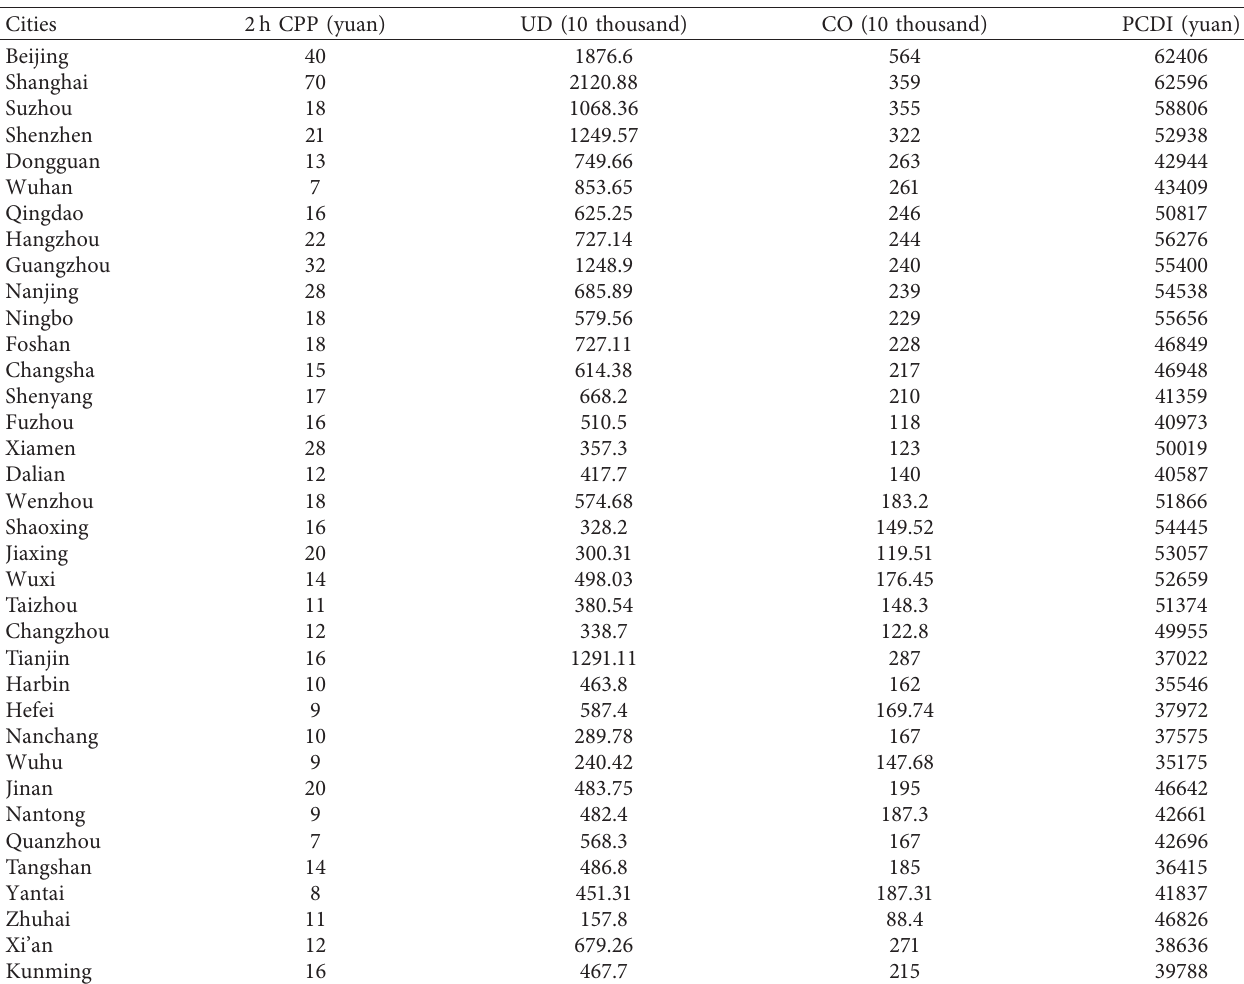
Table 1: The curb parking price in the core areas in RCs (2017).